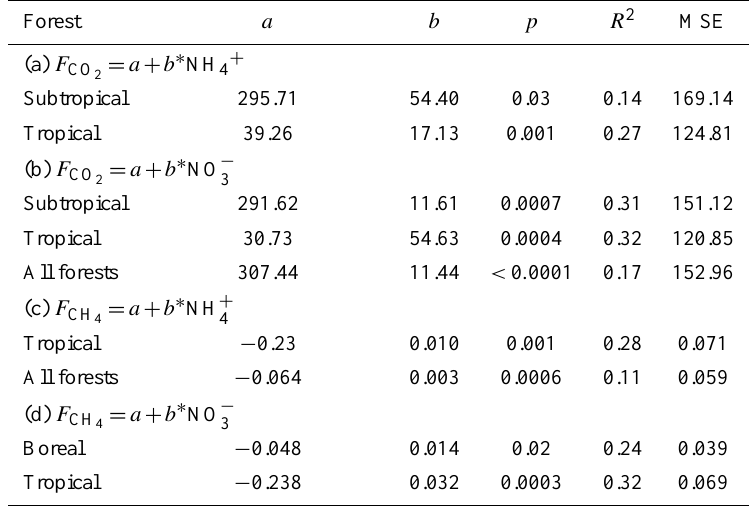
Table 4. Model parameters and coefficients for the relationship between the soil CO 2 and CH 4 fluxes and soil mineral N concentrations at the top 10cm soil